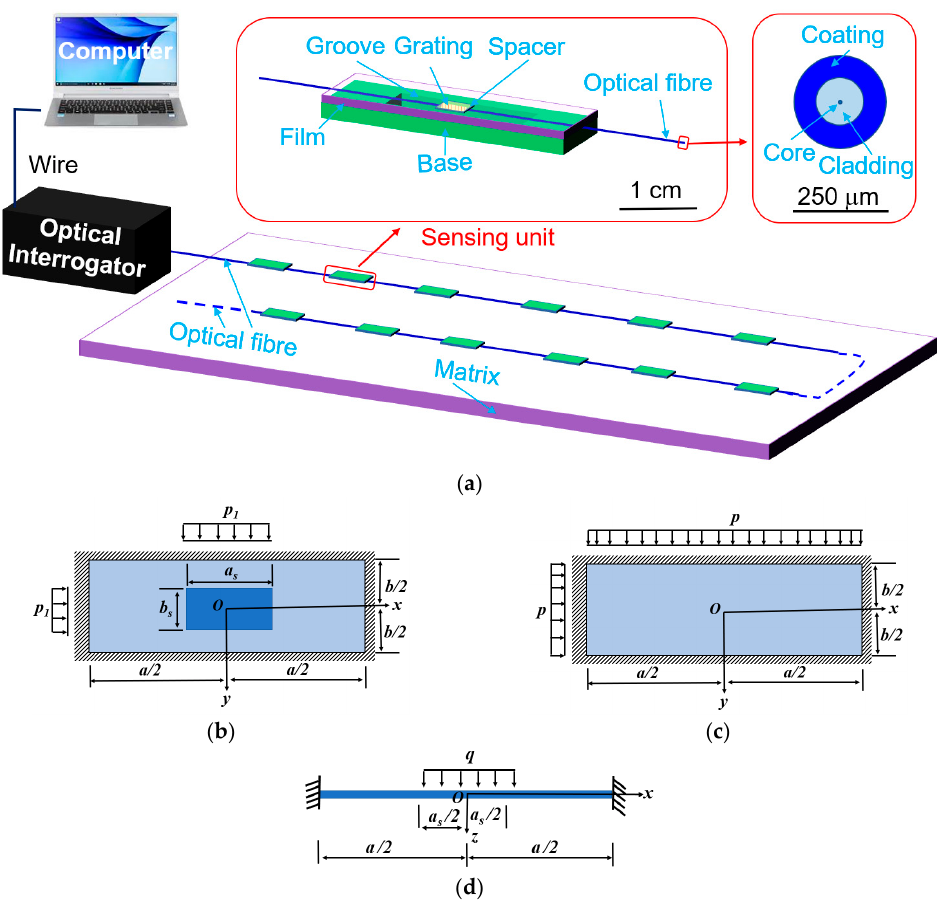
Figure 1. ( a ) Schematic of the smart skin with optical sensing networks and a measurement system, the proposed optical sensor, and the cross-section of optical fibre; Three models are utilised in theoretical analysis: ( b ) A simply supported rectangular plate under uniform load, p 1 , uniformly distributed on a rectangle zone at centre, which is corresponding to the size of the spacer; ( c ) A simply supported rectangular plate under uniform pressure; p , and ( d ) A built-in beam under a uniform load, q , at the centre part, which corresponds to the length of the spacer.